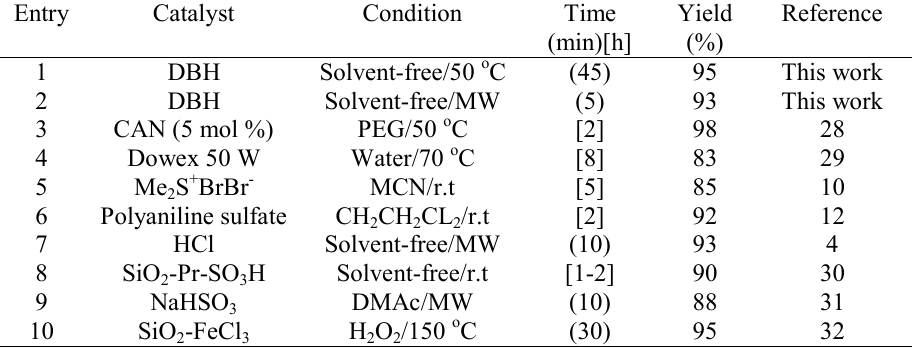
Table 3 . Comparison of efficiently various catalysts in the synthesis of